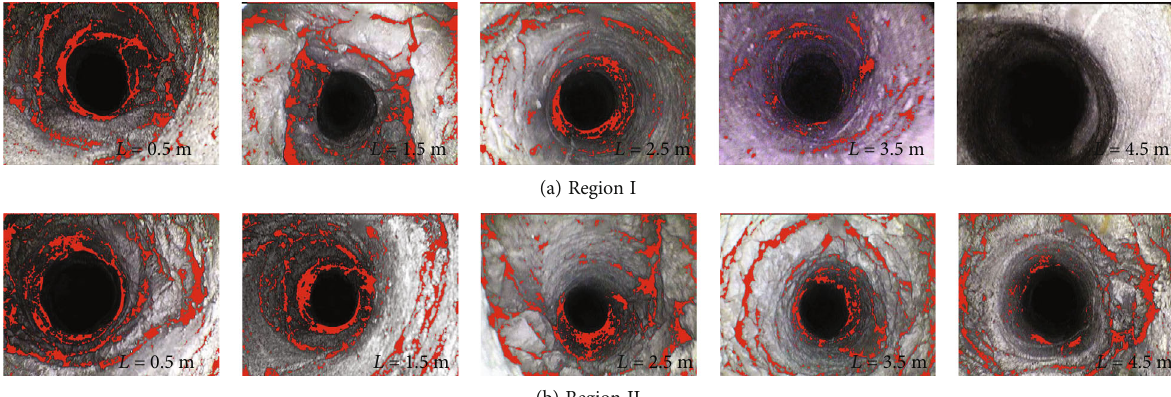
Figure 4: Fracture distribution morphology of roof in regions I and II under di ff erent borehole depths (note: the red represents identi fi ed cracks).